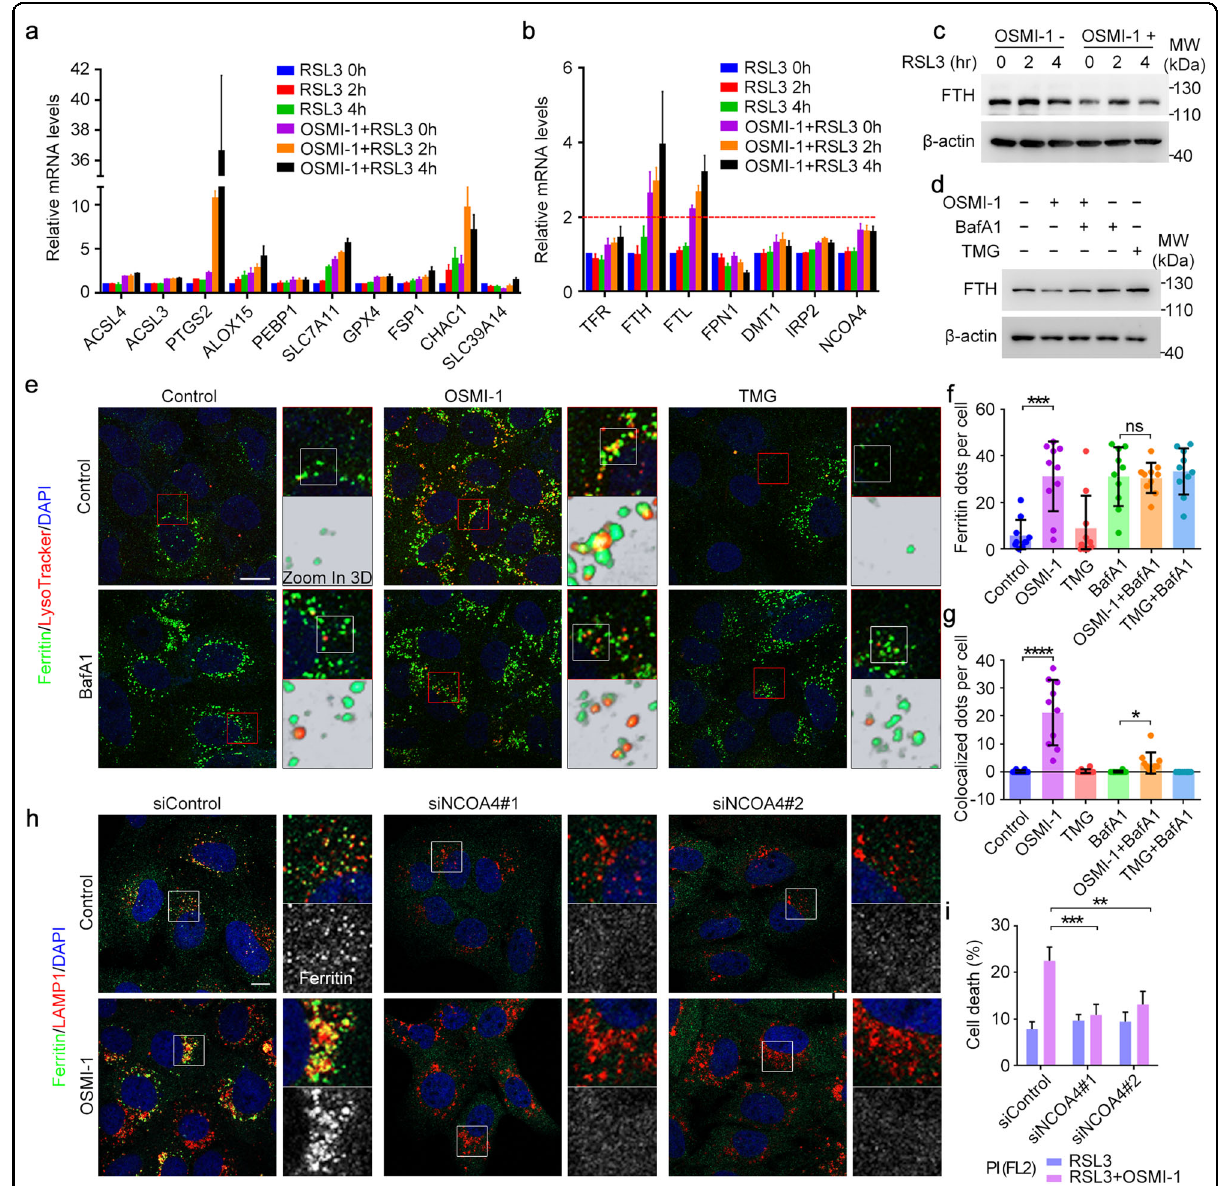
treated with RSL3 for different time as indicated. The relative mRNA levels were assessed by q-RT-PCR ( a , b ). Cells were lysed and immunoblotted with antibodies against FTH and β -actin ( c ). d U2OS cells were treated as indicated for 12 h and cell lysates were subjected to immunoblotting with antibodies against FTH and β -actin. e – g U2OS cells were treated as indicated for 24 h, stained with LysoTracker and then subjected to immuno fl uorescence microscopy with antibodies against Ferritin ( e ). Ferritin dots per cell ( f ) and co-localized dots of ferritin and LysoTracker per cell ( g ) were quanti fi ed. h U2OS cells were transfected with control or NCOA4 siRNAs for 48 h and subjected to immuno fl uorescence microscopy with antibodies against Ferritin and LAMP1. i U2OS cells were transfected with control or NCOA4 siRNAs for 48 h and treated with DMSO or OSMI-1 for 12 h, and then induced with RSL3 for 3 h. Cells were stained with PI and assessed by fl ow cytometry. Scale bars, 10 μ m. * P < 0.05, ** P < 0.01, *** P < 0.001, **** P < 0.0001; ns, not signi fi cant. Error bars indicate